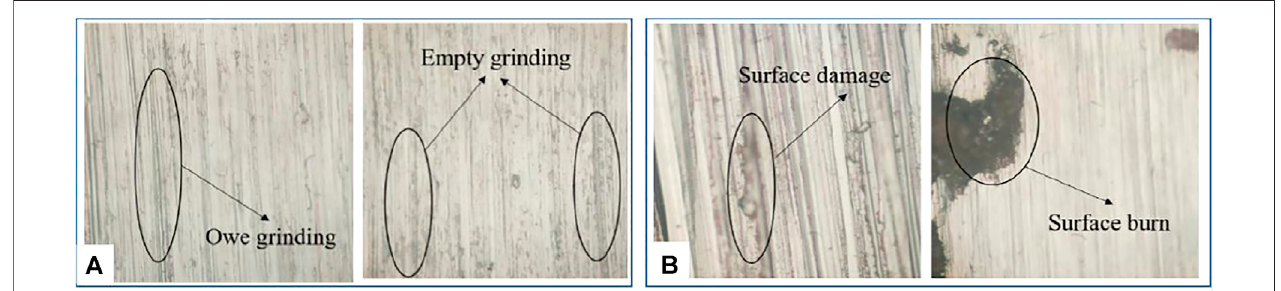
FIGURE5| Experimentalequipmentandtestingequipment. (A) Machinedsurfacewithsmallgrindingparameters. (B) Machinedsurfacewithgrindingparameters.